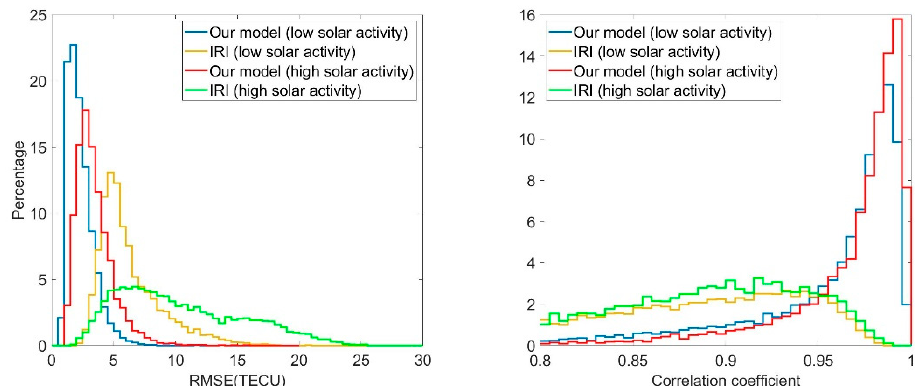
Figure 6. The distribution of the RMSEs ( left ) and CCs ( right ) between the output maps and the target maps during high solar activity years (red) and low solar activity years (blue), as well as between IRI TEC maps (+2 h) and target maps during high solar activity years (green) and low solar activity years (yellow).